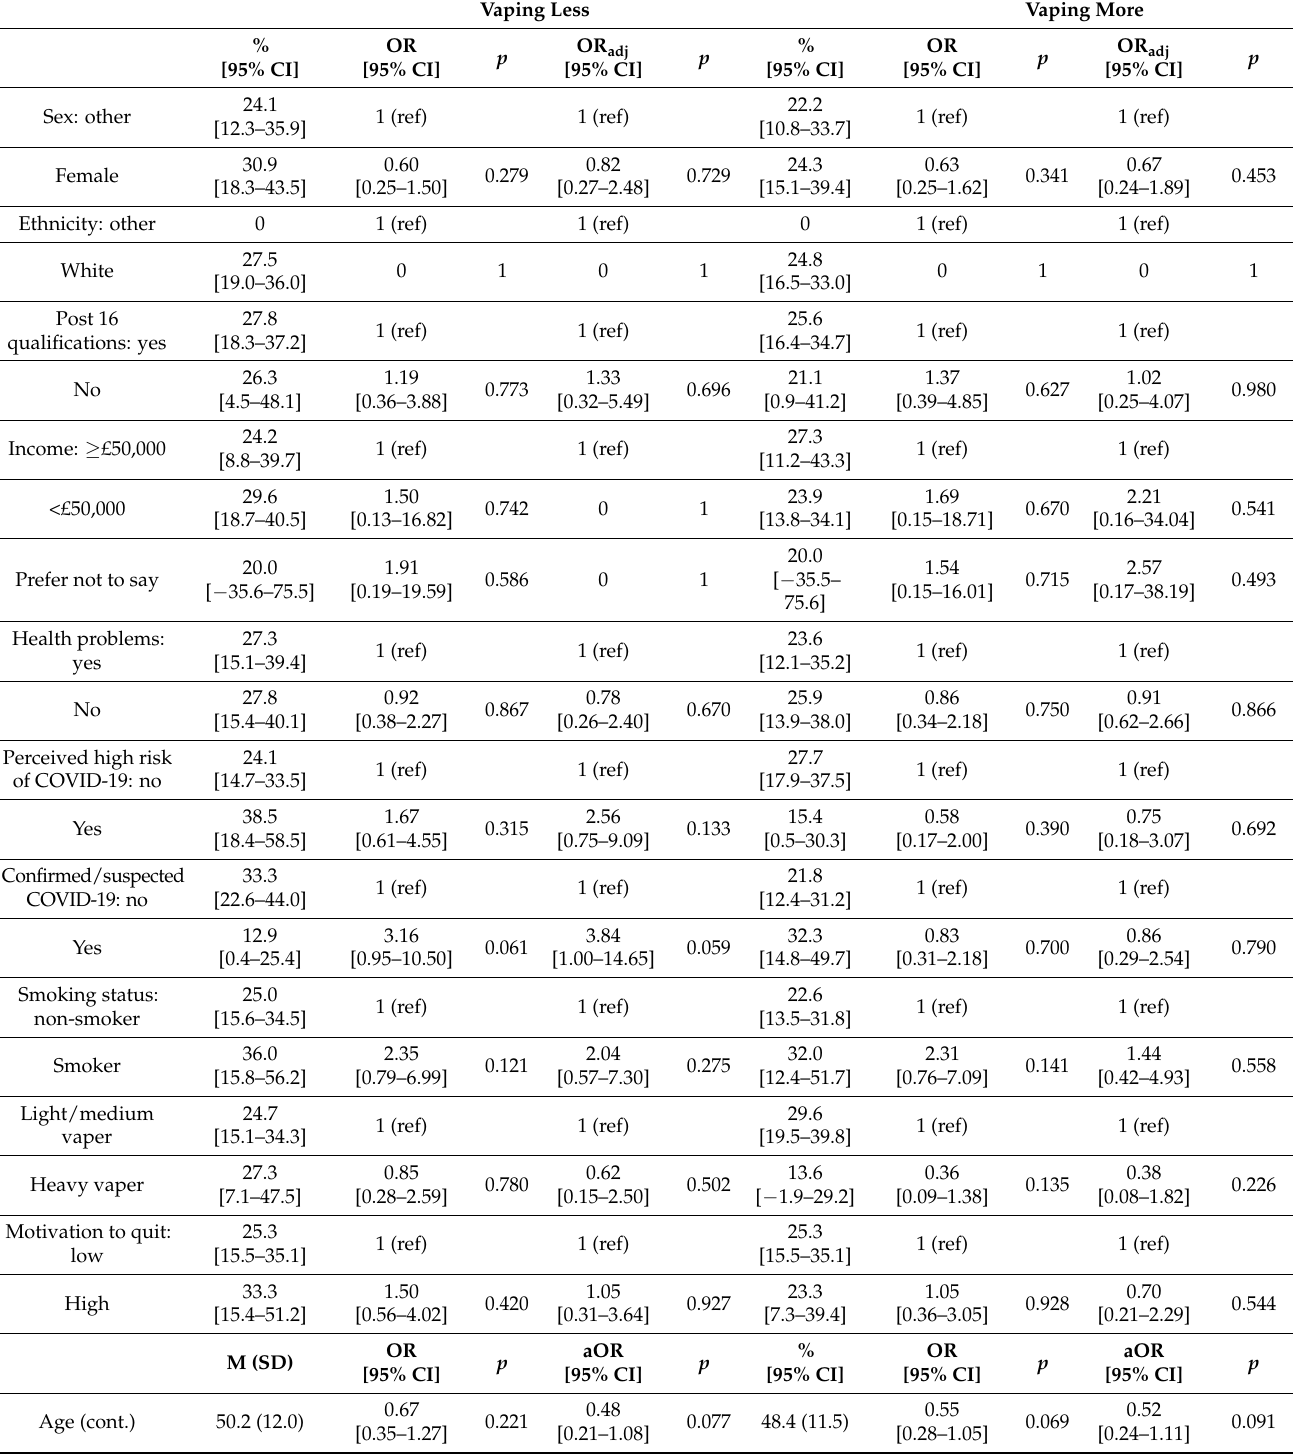
Table 5. Correlates of vaping less and vaping more frequently per hour per day between baseline and 12-month follow-up among current vapers at both time points (N =